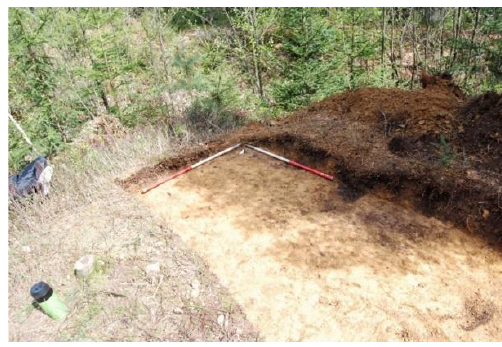
Figure 7. Probe 2 (view to the north).